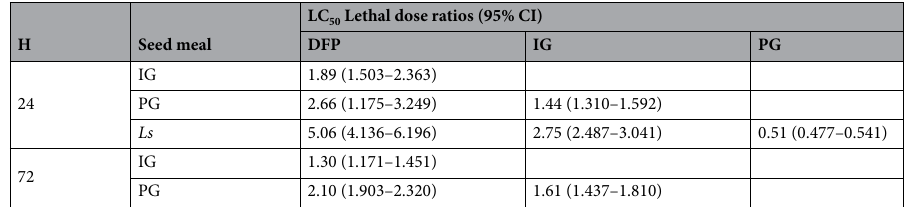
Table 3. LC 50 lethal dose ratio values with corresponding 95% CI showing significant differences between seed meals 24 and 72 h of continuous treatment exposure to Ae. aegypti larvae. Lethal dose ratio of a seed meal treatment in a column compared with a seed meal treatment in a row are statistically different from each other when the 95% CI of the LC 50 lethal dose ratio values did not include a value of 1.0, ( P =